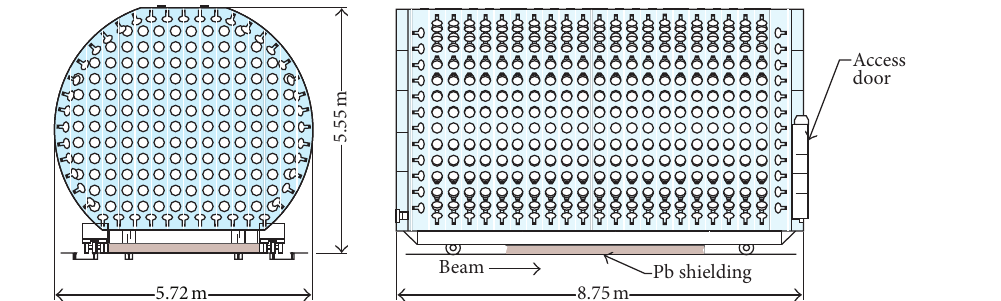
→ ] 𝜇 𝑒 transmutation and 𝑝 → 𝜇 + 𝑛 scattering. The 𝜇